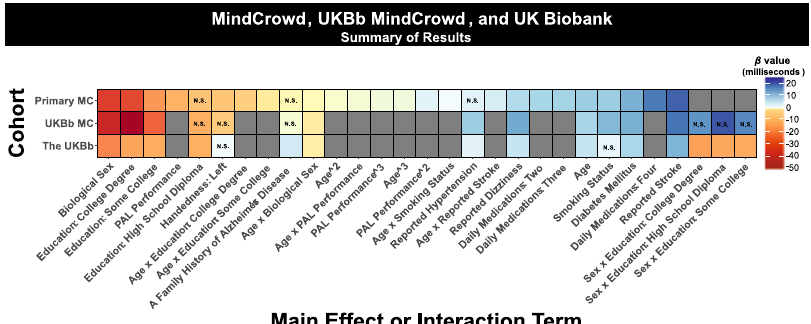
Fig. 9 An illustrative summary of the overall results. Data are shown across the MindCrowd (MC), UKBb MindCrowd, and the UK Biobank (UKBb). The color (i.e., red = low negative and blue = high positive) indicates the size of the β (beta coef fi cient) estimate. ” N.S., ” indicates if the estimated β value was not statistically signi fi cant ( α =